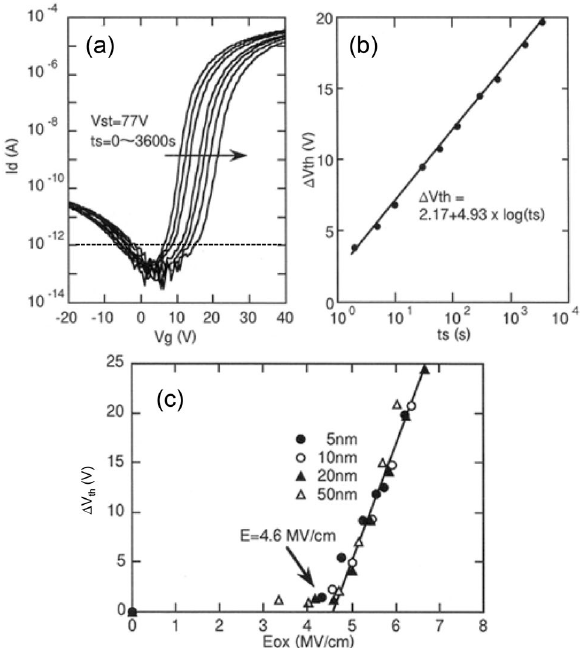
Figure 6. Effect of bias temperature stress (BTS) on TFT characteristics. ( a ) The transfer (Id–Vg) curve shifts in the positive direction with positive gate bias stress of Vst = + 77 V over the duration of 0–3600 s. ( b ) ΔVth, defined as the Vth shift from the initial value via BTS, increases logarithmically with increasing t S , following ΔVth = 2.17 + 4.93 × log (t S ). ( c ) ΔVth of MNOS TFTs with different SiOx thicknesses from 5 to 50 nm as a function of the electric field applied to the SiOx